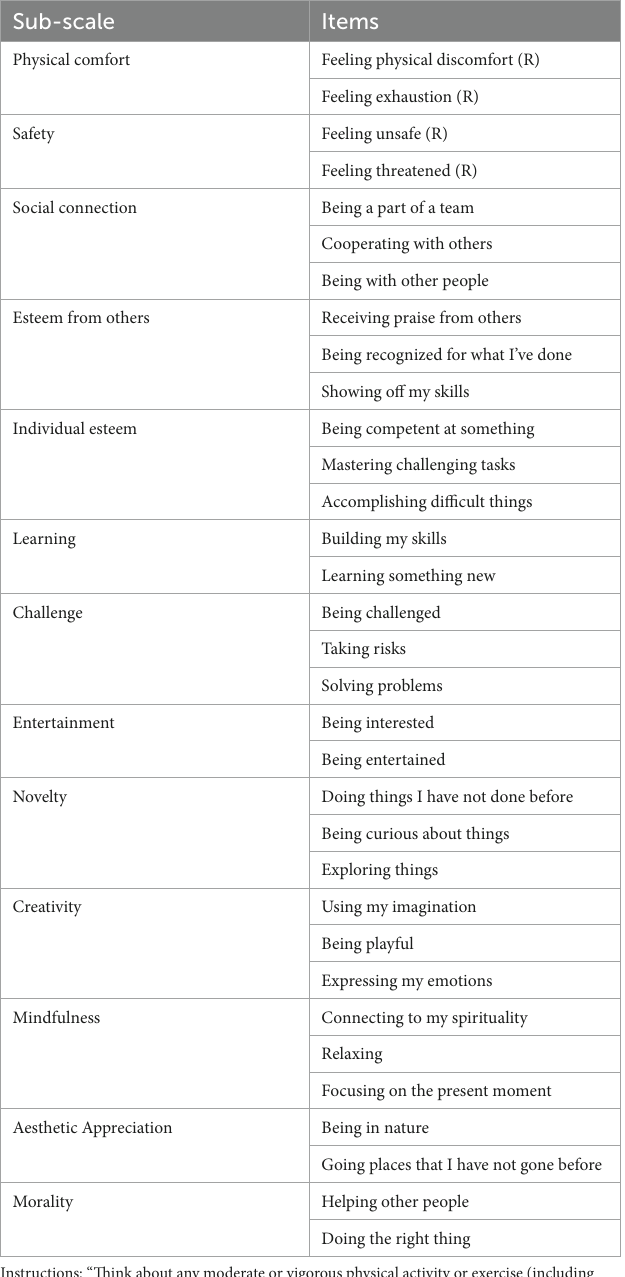
TABLE 2 Satisfaction of psychological needs through physical activity instrument (33 items).